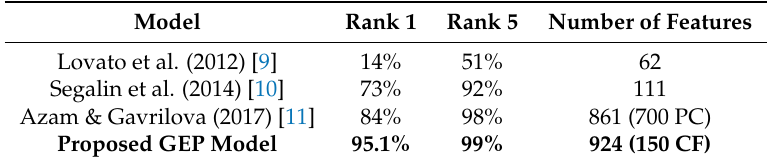
Table 4. Summary comparison of rank 1 accuracy, rank 5 accuracy, and number of features with state-of-the-art works.